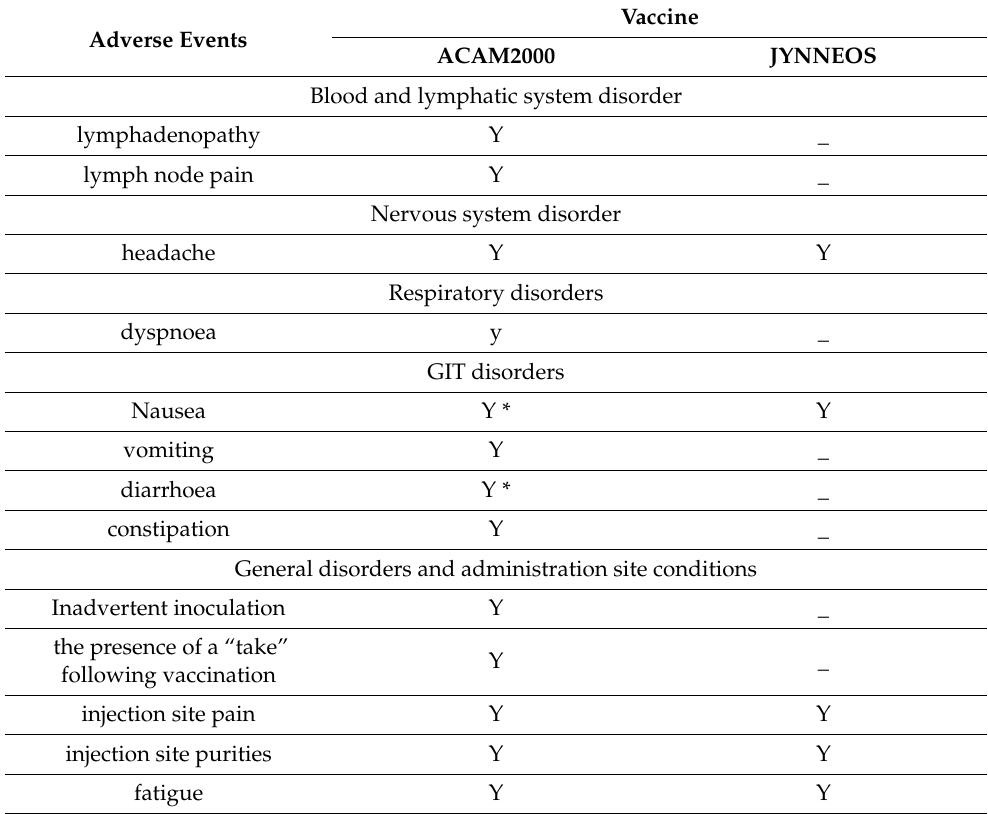
Table 4. Reported adverse events to the two licensed vaccines for monkeypox. Adverse